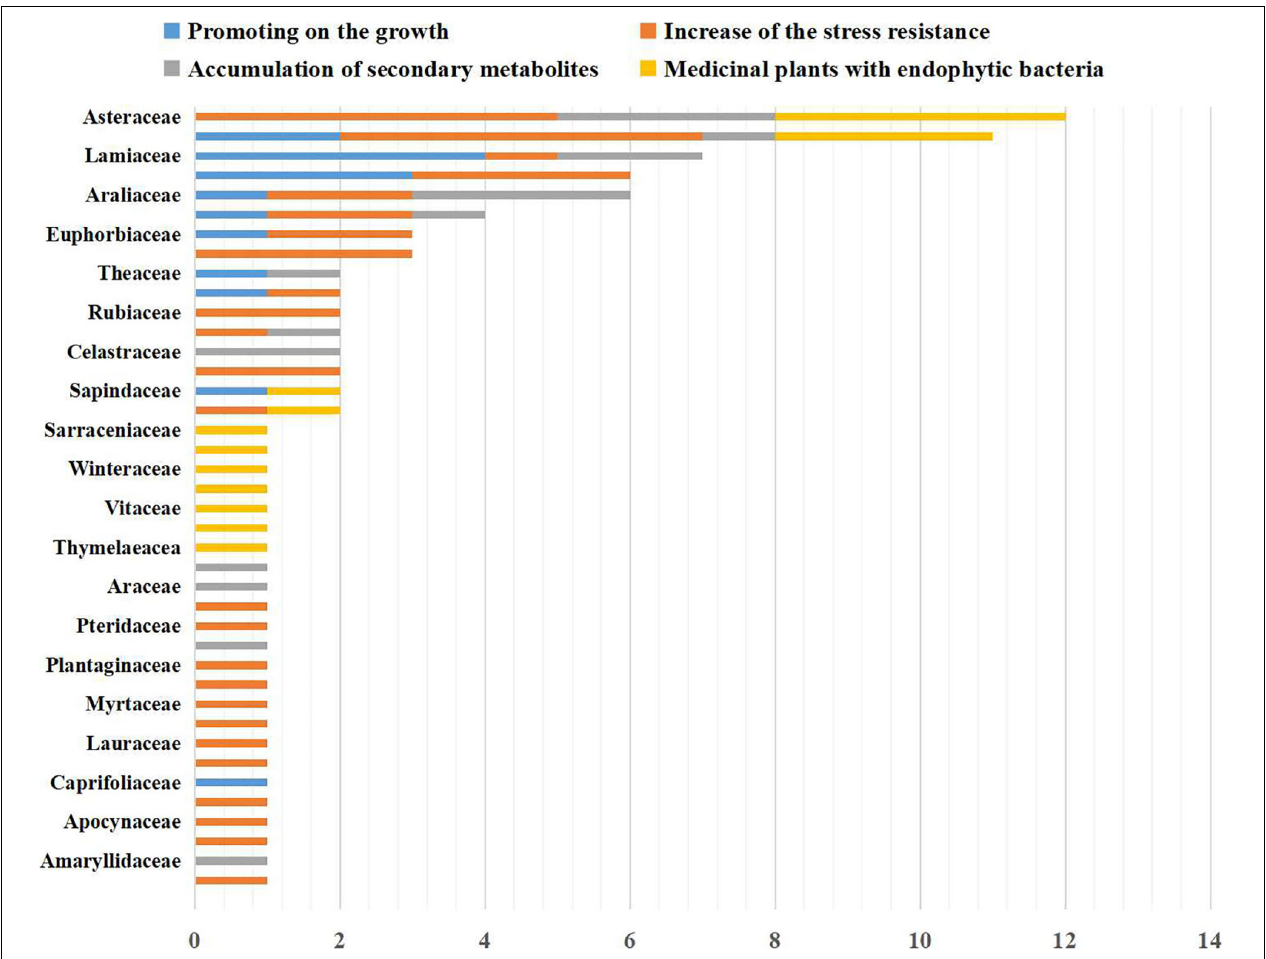
FIGURE 1 | Taxonomy of the 86 species of medicinal plants included in the survey and reference analysis ( x -axis: number of species in the family; y -axis: type of